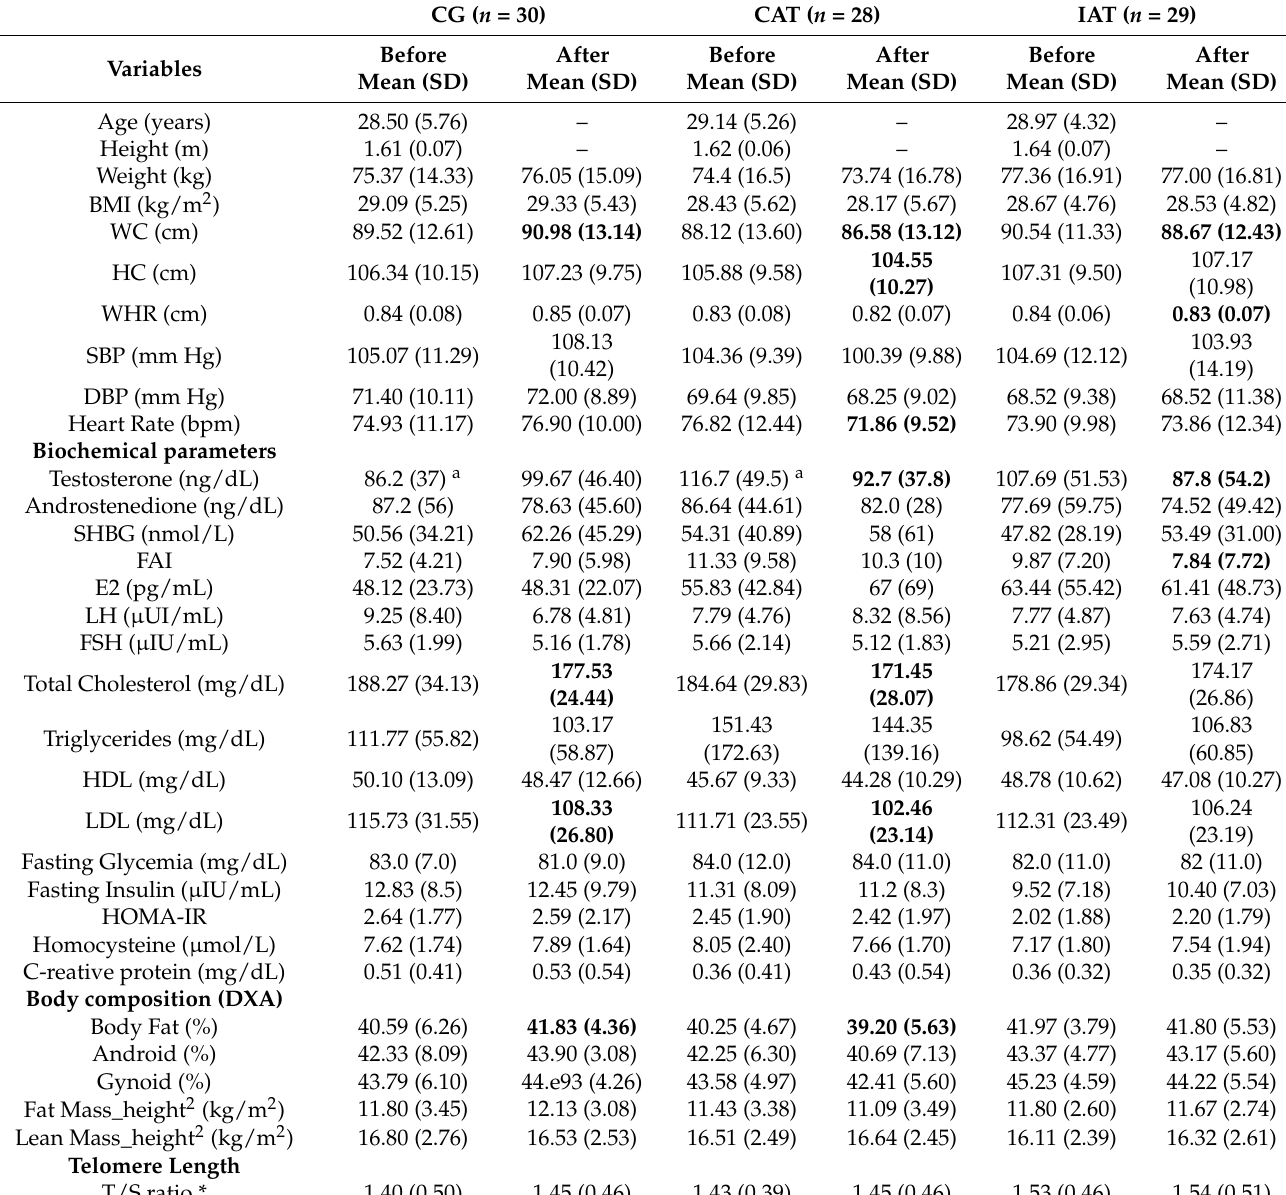
Table 1. Clinical, anthropometric, hormonal and metabolic parameters of women with PCOS before and after the aerobic physical training protocols or observation